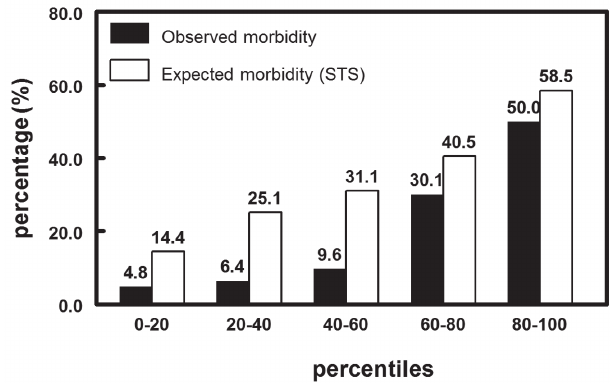
Fig. 2 – Observed (black columns) and expected (mean, white columns) general morbidity rates distributed according to the quintiles of expected mortality, as calculated by the STS scoring system. Goodness of fit Chi-square test has shown that the pattern of distribution of expected and observed morbidity rates did not significantly differ in the study population (X 2 =6.77, P=0.15)